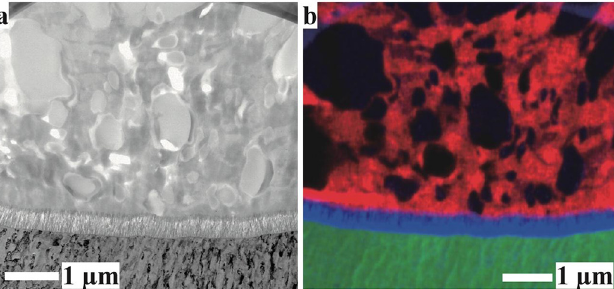
Fig. 15. (a) STEM-BF cross-sectional image and (b) STEM- EDX mixed map of S (red), O (blue), and Al (green) of the fracture surface of Al after the fracture test. The surface treatment is NMT2.